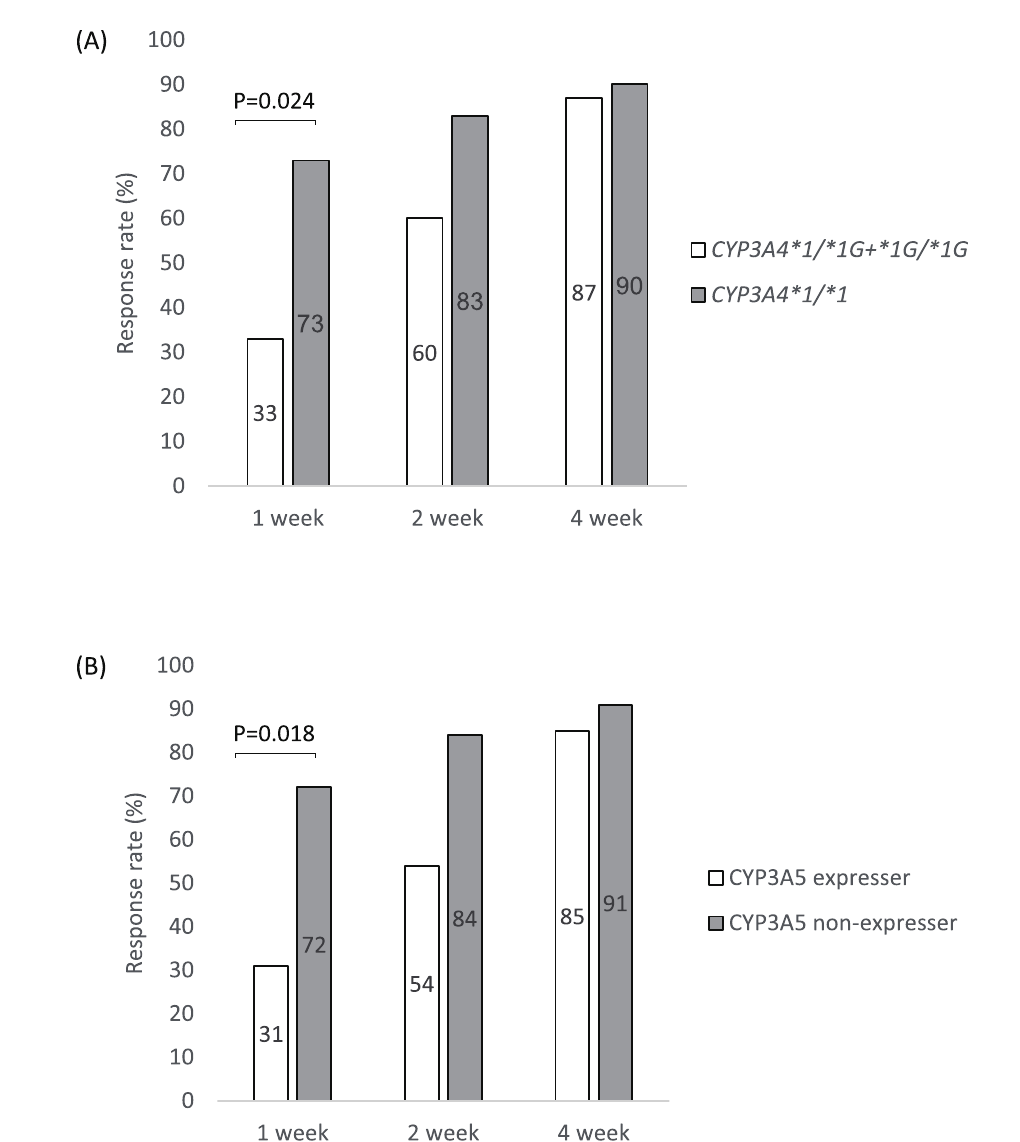
ment, and laboratory data before Tac induction were analyzed to identify factors affecting the therapeutic effects of Tac. The univariate logistic regression analysis indicated CYP3A4 and CYP3A5 polymorphisms as significant factors involved in the therapeutic effect of Tac (Table 4). For these polymorphisms, a multivariate logistic regression model after adjusting for age and p-Mayo revealed both CYP3A4 and CYP3A5 polymorphisms as significant factors affecting the therapeutic effects of Tac with similar odds ratios (ORs): CYP3A4 � 1 / � 1 (OR: 0.15,